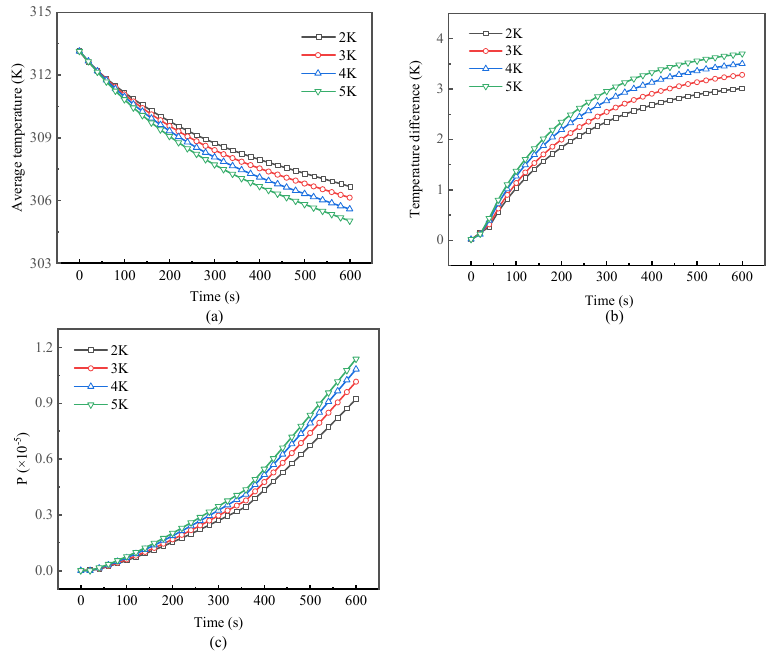
Figure 9. The effects of subcooling degree. ( a ) Average temperature of the module; ( b ) Temperature uniformity of the module; (c) Battery consistency in the module.